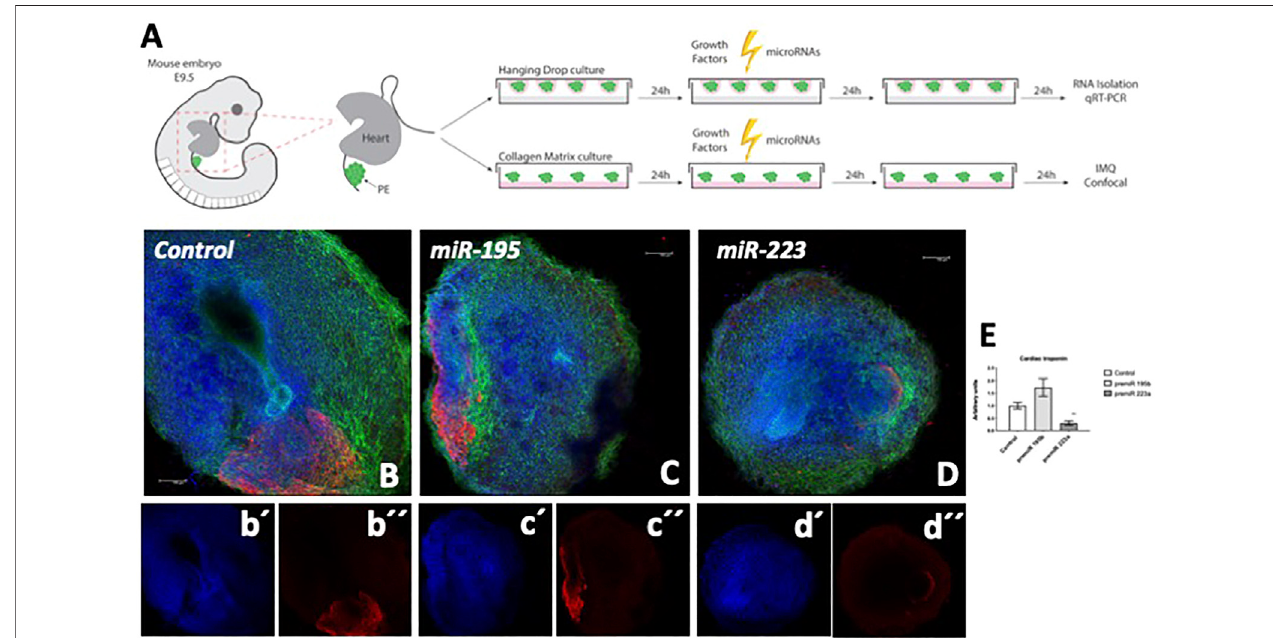
FIGURE1| Panel (A) Schematicrepresentation ofthe experimental design ofmouse PE/ST isolation, transfection withmicroRNAsor growth factor administration and subsequent analyses. Panels (B – D) Confocal microscopy analyses ofcardiac troponin expression (red) in mouse E9.5PE/ST explantstreated withcontrol (B) miR- 195mimics (C) ,miR-223mimics(D),respectively.SinglechannelconfocalimagesofDapiandcardiactroponinaredepictedforcontrol(b´,b´´),miR-195(c´,c´´)andmiR- 233 (d´, d´´) treated explants, respectively. Panel (E) displays quantitation of mean cardiac troponin positive areas in each experimental condition ( n (cid:2) 5). Note that the cardiac troponin expression is similarly observed in miR-195 treated explants and controls, while a signi fi cant decreased in miR-223 treated explants is observed. Blue (DAPI), phalloidin (green).